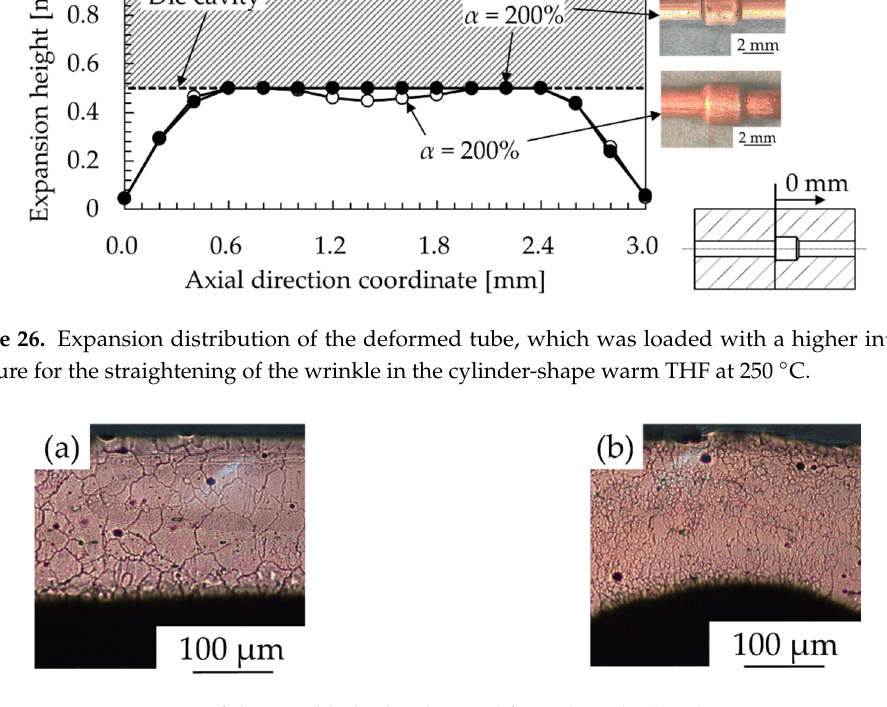
Figure 28. Radius shape of the corner of the deformed tubes: ( a ) taper-shaped tube; ( b ) cylinder- shaped tube. 4. Conclusions In this study, warm THF at 250 °C for small-diameter ZM21 magnesium alloy tubes with an outer diameter of 2.0 mm and a wall thickness of 0.2 mm was examined by experimentation and FEM analysis. The influence of the loaded internal pressure and the axial compressive displacement on the deformation characteristics, the forming limit, and the forming defects of the tubes were examined and evaluated. The results obtained in this study are summarized below.